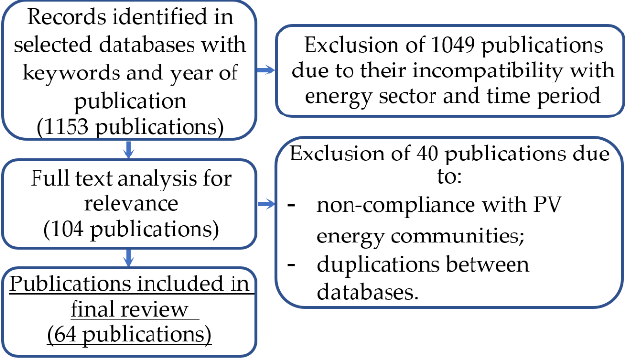
Figure 2. Literature selection methodology.